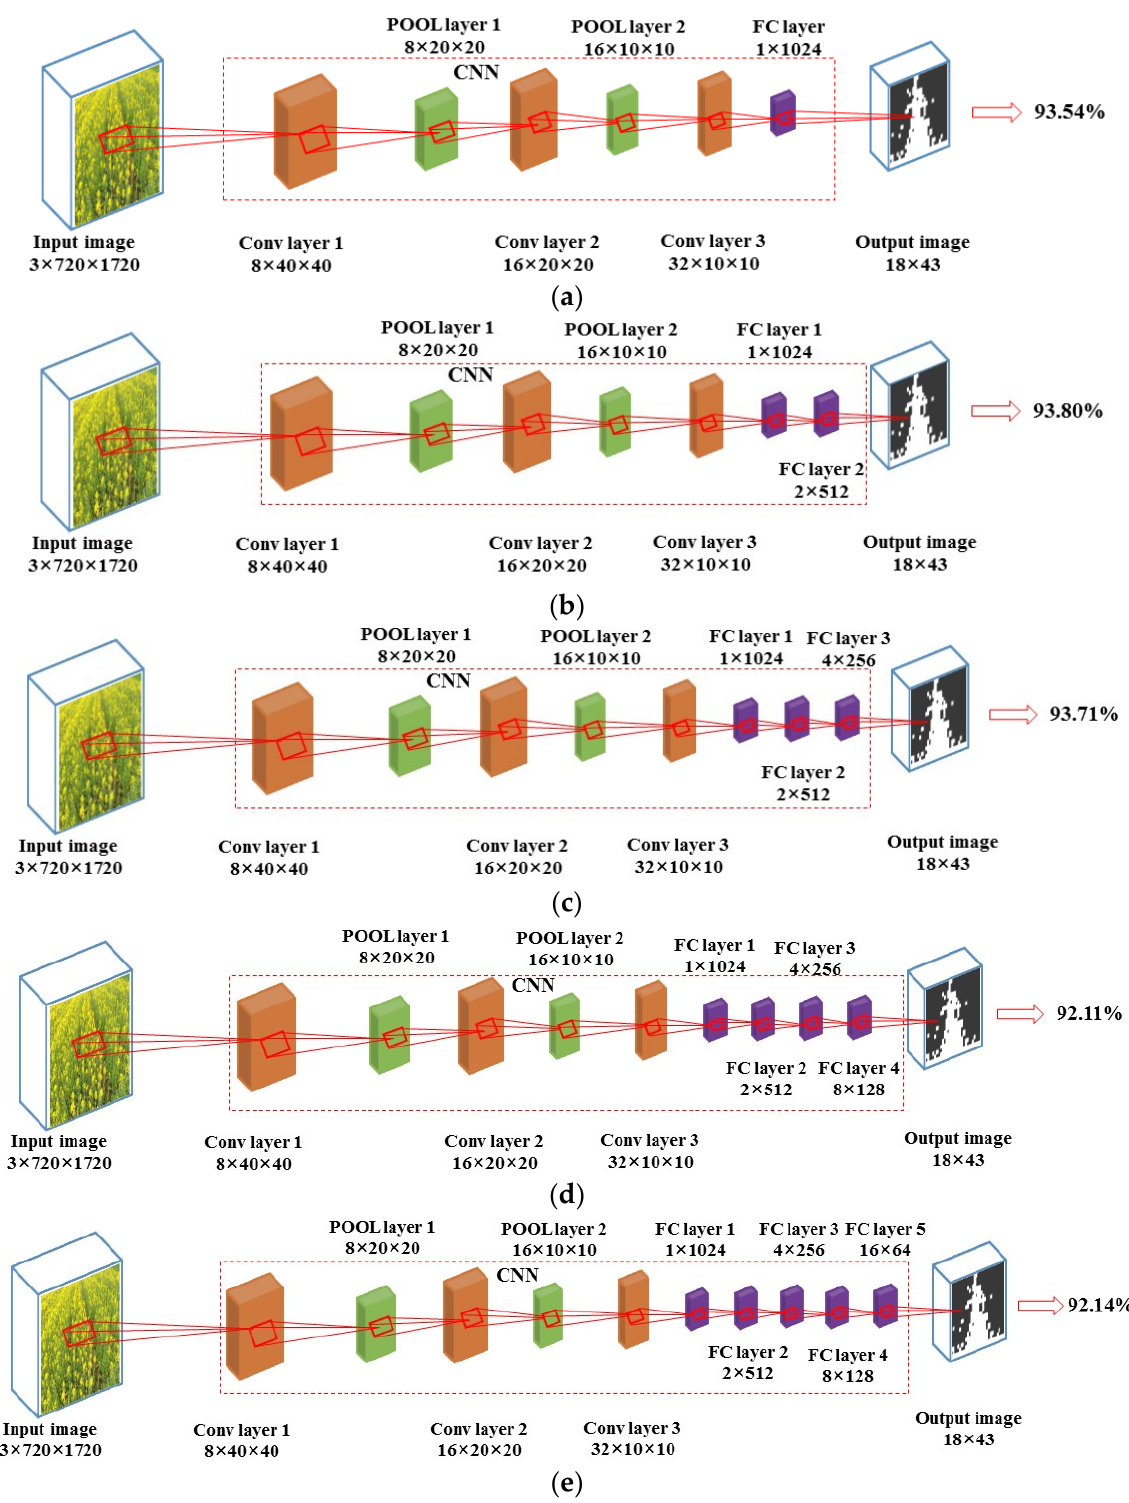
Figure 7. CNN recognition accuracy analysis of different FC layers with three Conv layers; ( a ) Accuracy of C3 + FC1 CNN structure; ( b ) Accuracy of C3 + FC2 CNN structure; ( c ) Accuracy of C3 + FC3 CNN structure; ( d ) Accuracy of C3 + FC4 CNN structure; ( e ) Accuracy of C3 + FC5 CNN structure.